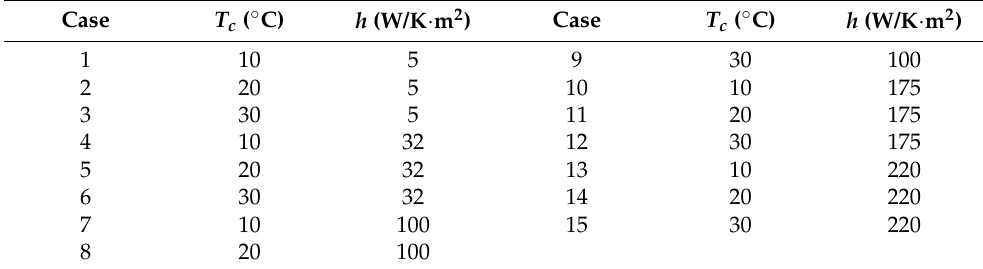
Figure 10. The verification of battery pack at different ambient temperature with 1C discharge rate: ( a ) temperature increase, ( b ) terminal voltage.